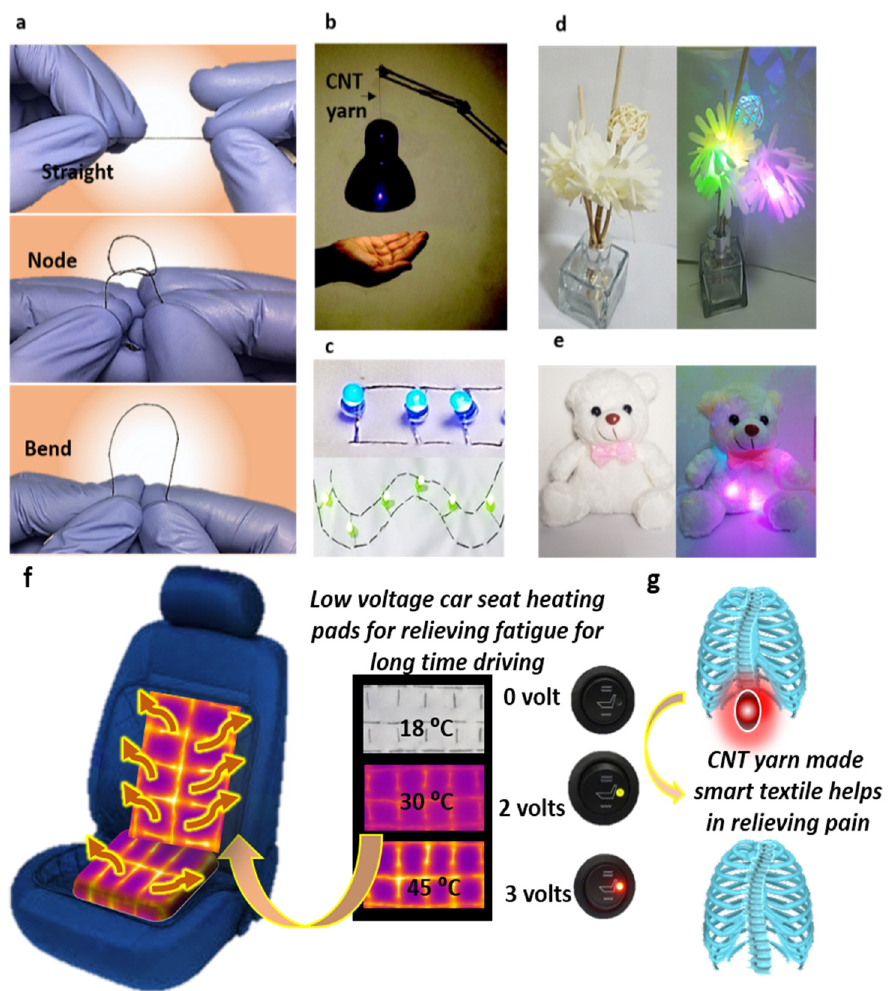
Figure 6. ( a ) Showing flexibility of cross-linked CNT yarn, i.e., straight, node, and bend; ( b ) Application of esterified CNT yarn as a conductor in hanging lamp; ( c ) Demonstrating sew-ability of CNT yarn into the fabric with LED; ( d – e ) Practical application of CNT yarn in home decoration; ( f ) Application of CNT yarn as a car seat heating pads with low supplied voltages; and ( g ) Showing relief of muscle.